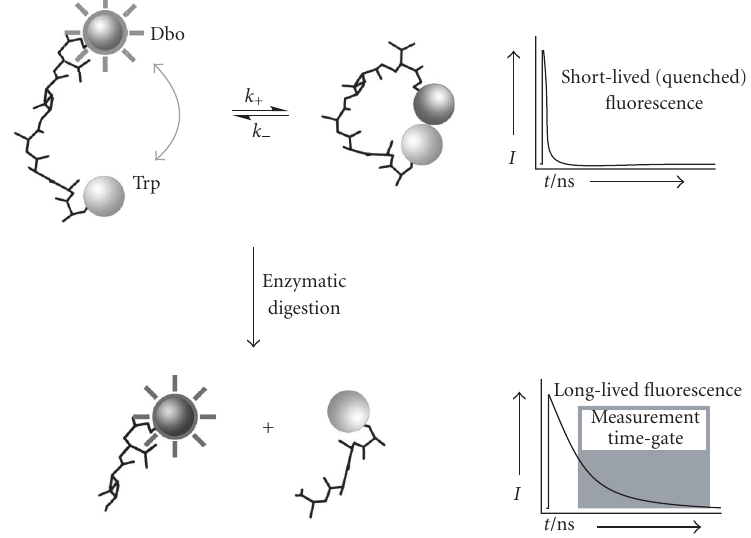
Scheme 3: Principle of protease assay based on probe/quencher-labeled